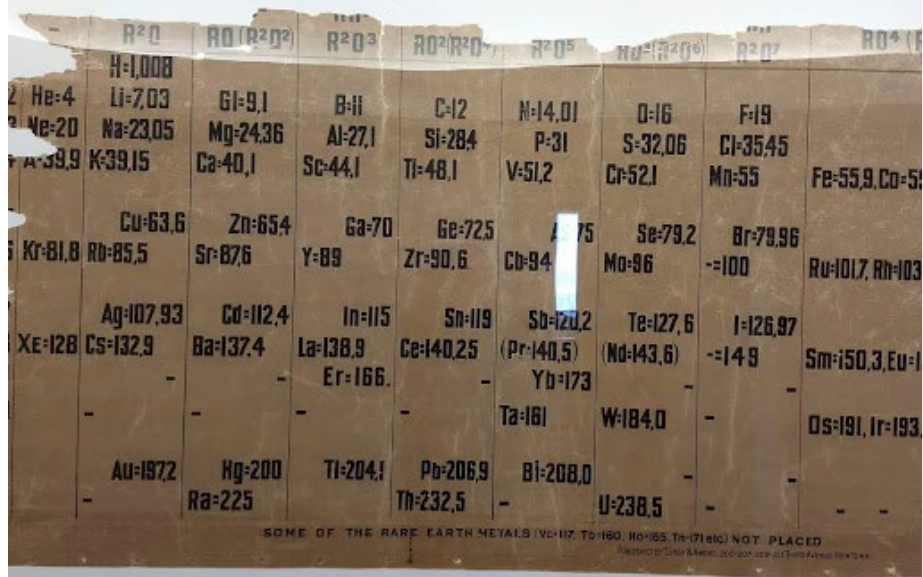
Figure 6. Table at the Department of Chemistry and Biochemistry, University of Northern Iowa, Cedar Falls. Courtesy of Laura Hoistad Strauss.